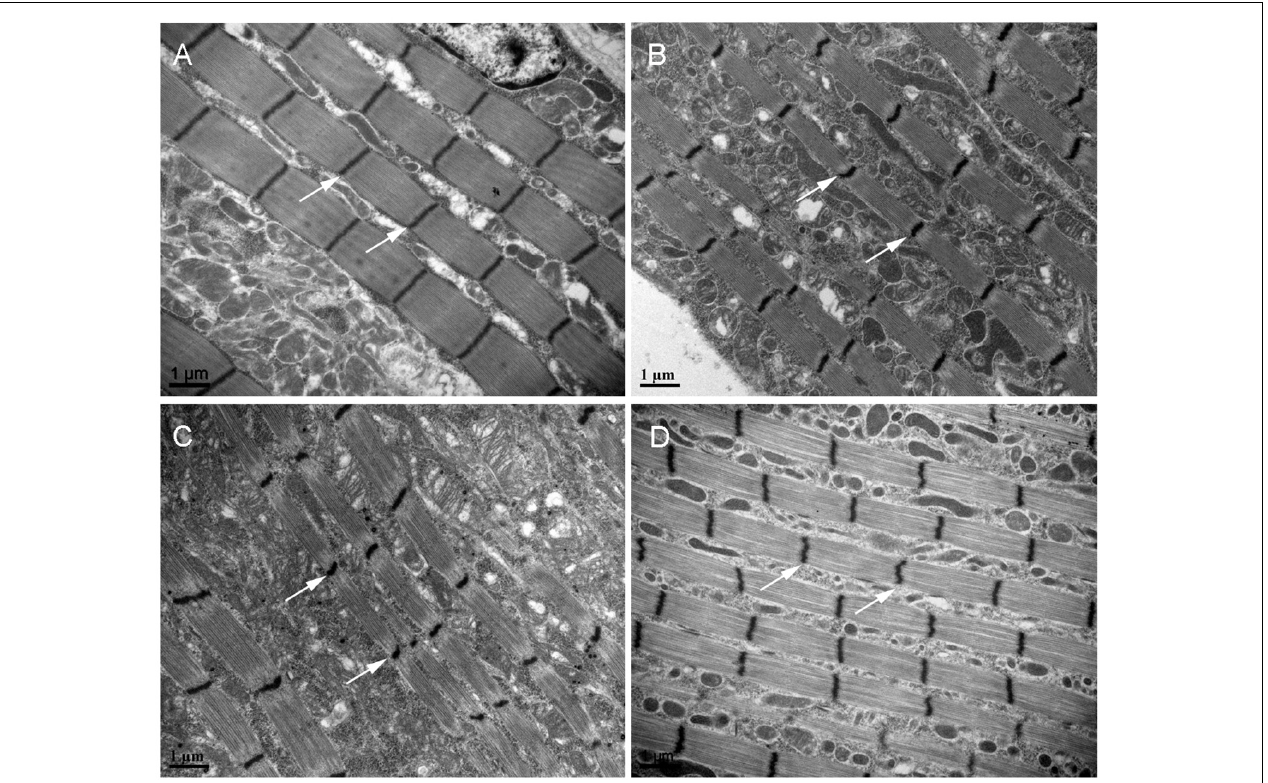
FIGURE 6 | TEM of the IFM of dsRNA-treated long-winged BPHs. Fourth-instar nymphs were treated with dsRNAs targeting Gfp (A) , NlNF-YA (B) , NlNF-YB (C) , or NlNF-YC (D) . Thorax was dissected from female adults (24 h after eclosion) for TEM. The Z discs are indicated by arrows.